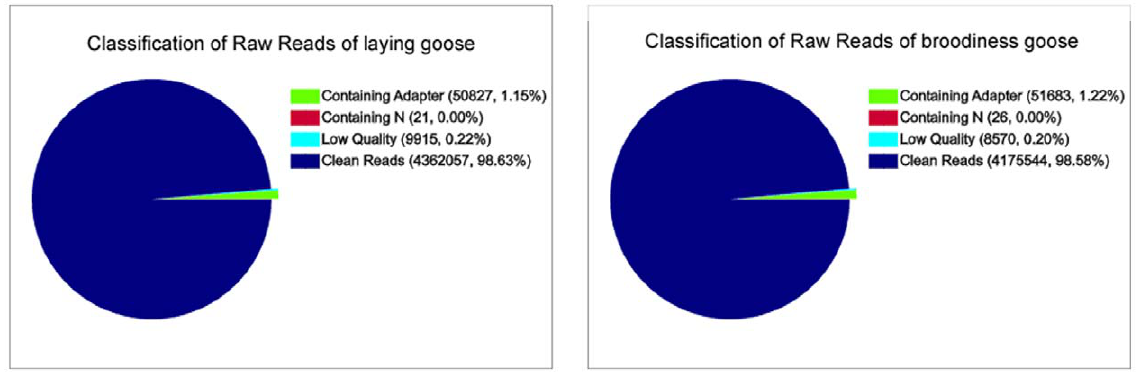
Figure 5. Different components of the raw reads in each sample. The percentages of tags containing N, adaptors, clean tags and low quality reads. The numbers in parentheses indicate the percentage of each type of read among the total raw reads.